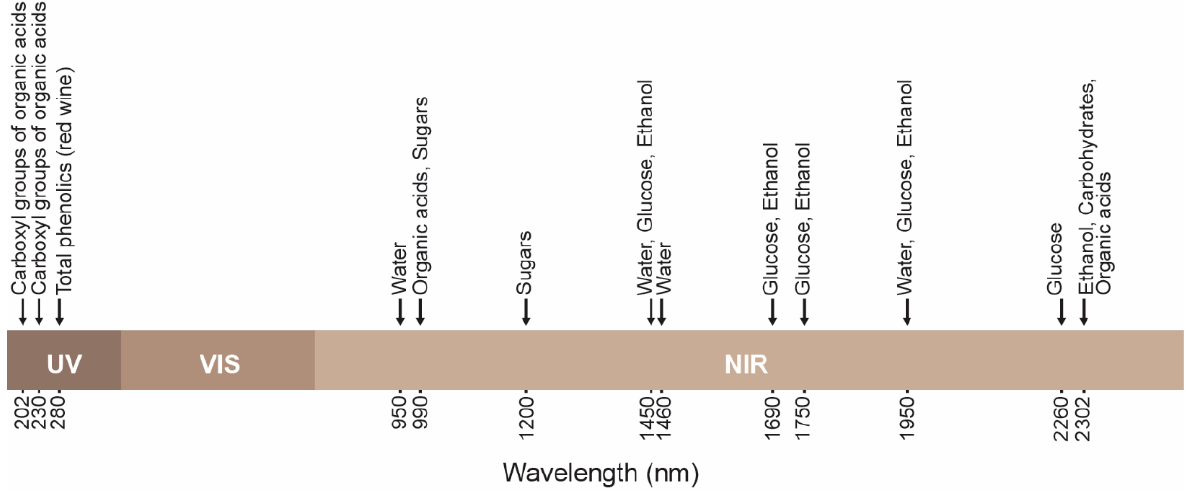
Figure 2. The main UV/VIS/NIR wavelengths associated with chemical compounds in grapes.